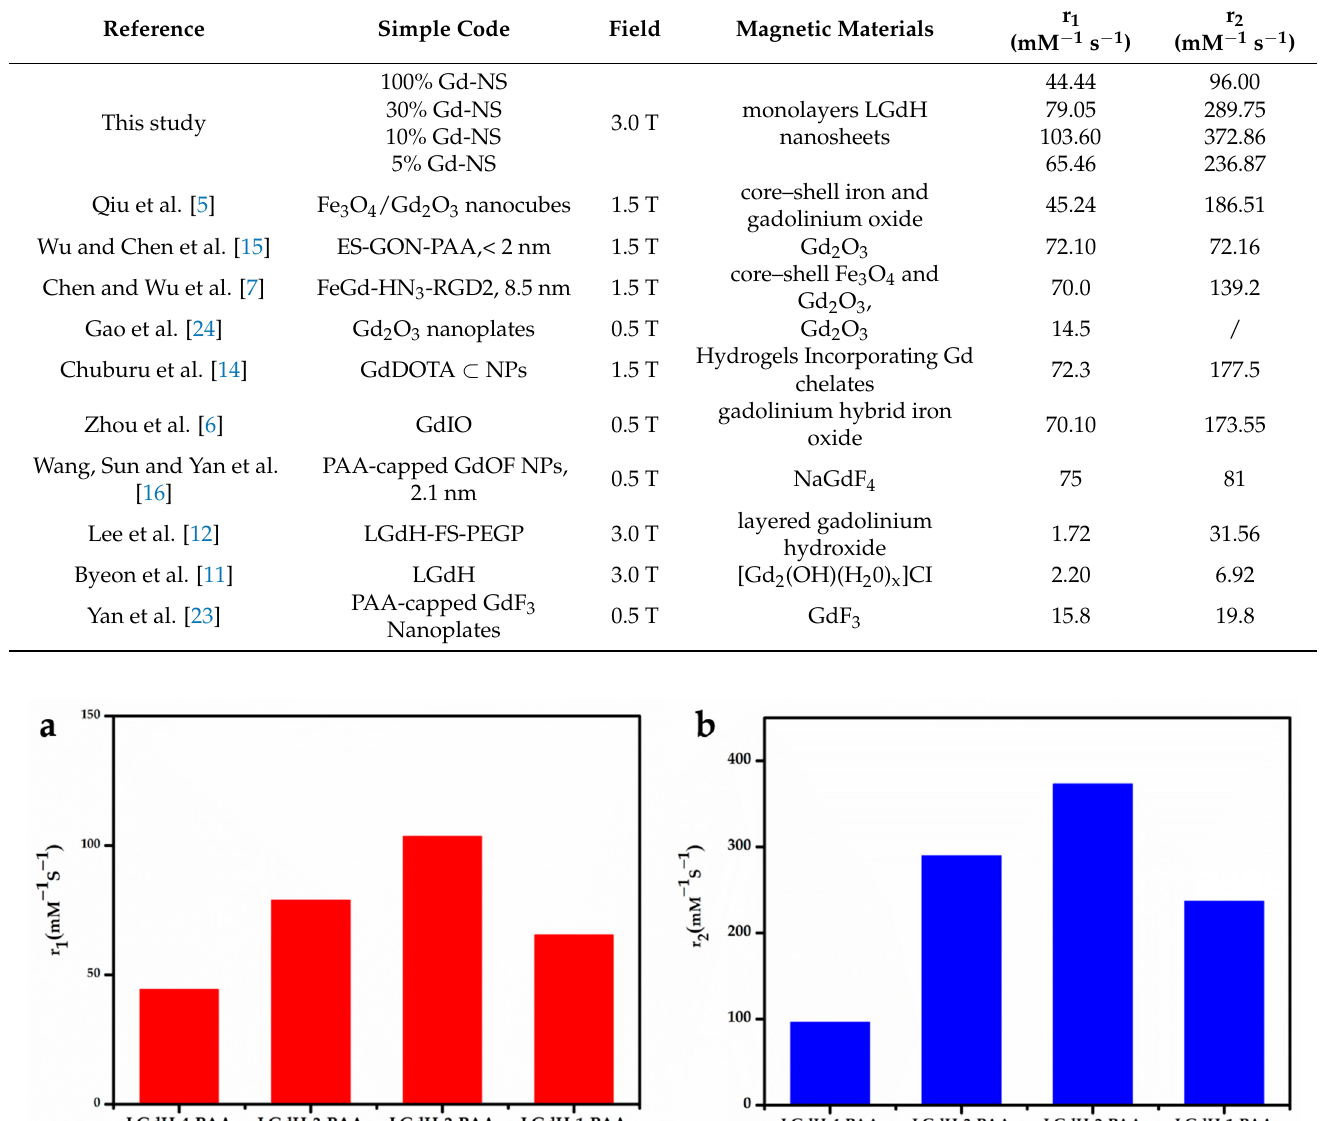
Figure 4. The r 1 ( a ) and r 2 ( b ) relaxivities (mM − 1 s − 1 ) of a series of Gd 3+ -doped LRH-nanosheet sol. The T 1 - and T 2 -weighted images of all the samples at 3T were acquired, as shown Table 1. Summary of magnetite nanoparticles for r 1 and r 2 relaxivity.